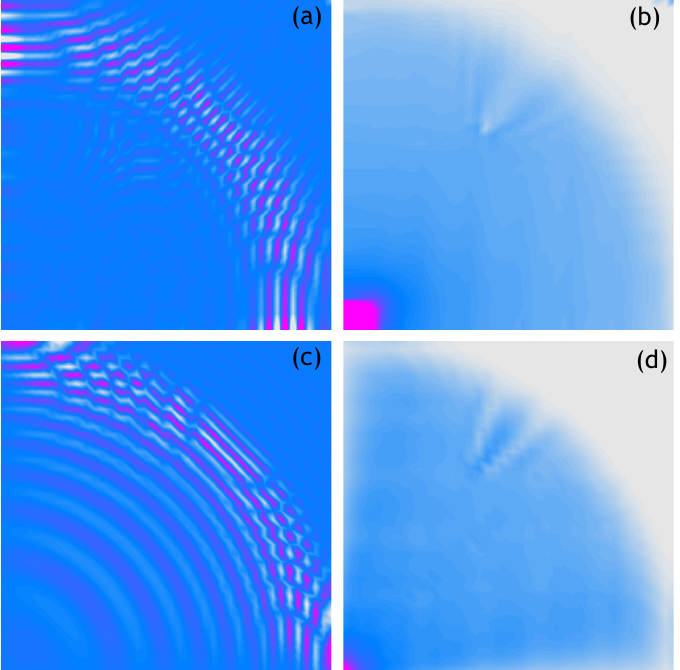
Figure 6. Wave propagation velocity patterns registered at 0.8 ms with 40 × 40 mesh grid, ( a ) Experi- mental data, ( b ) RMS of experimental data, ( c ) Calculated data, ( d ) RMS of calculated data.